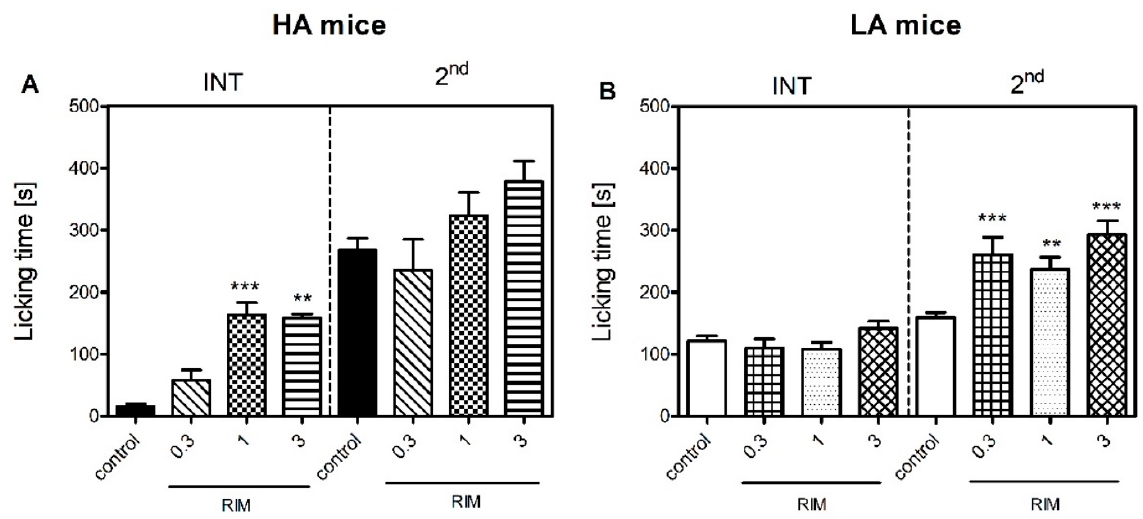
Figure 3. The effect of rimonabant (0.3–3 mg/kg, i.p., RIM) on acute inflammatory pain sensitivity in HA ( A ) and LA ( B ) mice in the formalin test ( n = 9–13) upon injection of 5% formalin (in PBS) into the dorsum of the hind foot. RIM was administered 15 min prior to formalin. Paw licking time was measured in the interphase (INT, 5–20 min) and the second phase (2nd, 20–60 min) of the test. Results were analysed with two-way ANOVA with treatment and phase as independent factors and with one-way ANOVA within each phase for each mouse line, followed by Bonferroni’s post-hoc test. Statistical significance was depicted as follows: ** p ≤ 0.01; *** p ≤ 0.001 (vs. control within each phase and line).